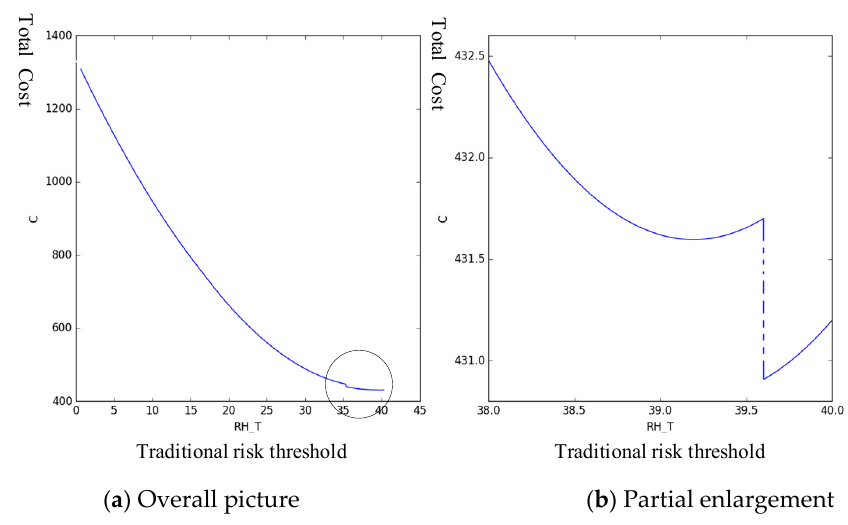
Figure 9. Trend in total costs under new different risk thresholds.